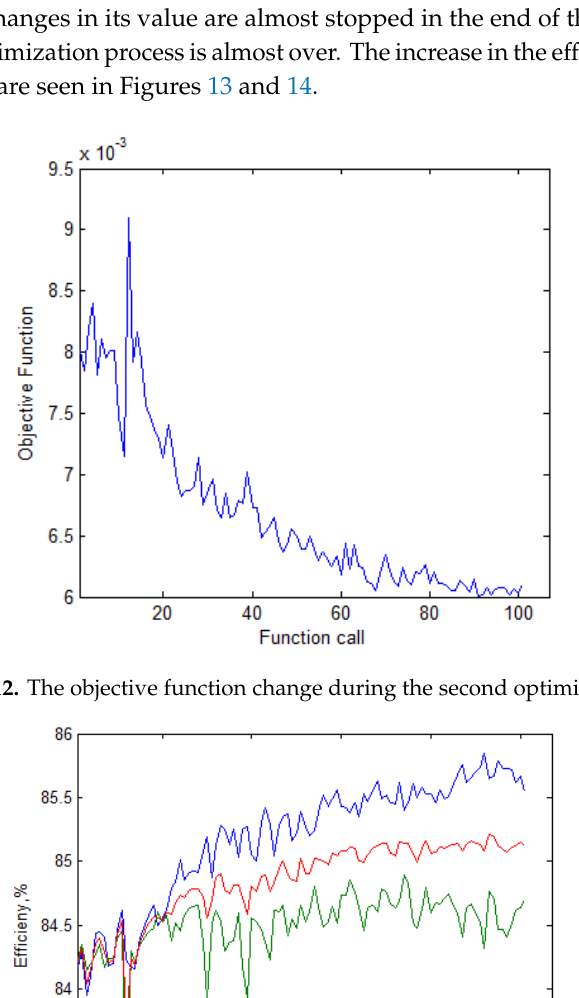
Figure 14. Change of the motor torque oscillations during the second optimization. Figure 15 shows the decrease in PPTR and increase in the minimum instantaneous torque ripple. Changes in the current and voltage waveforms are shown in Figures 16 and 17.